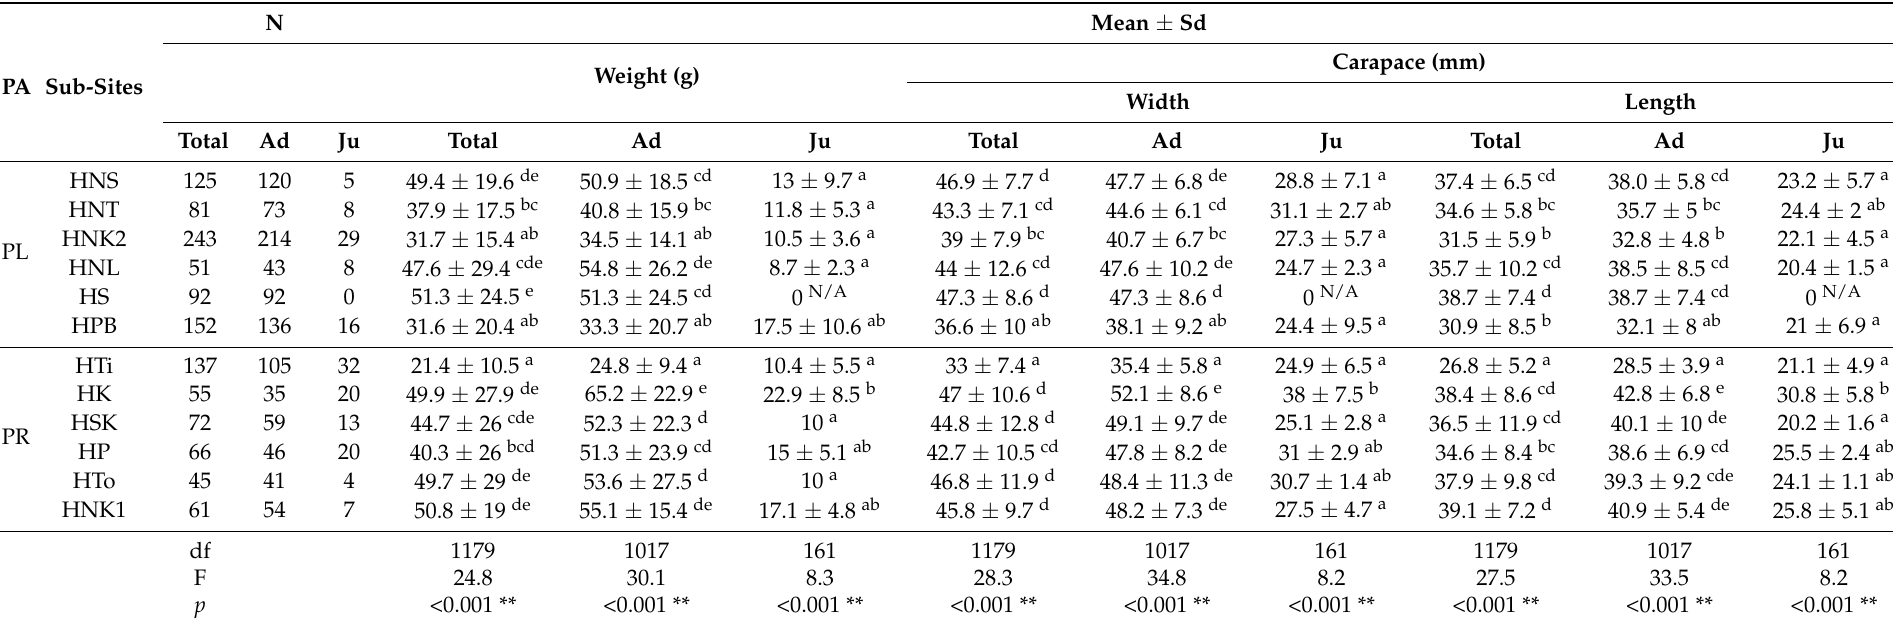
Table 3. Average body size of I. bhumibol in Phu Luang Wildlife Sanctuary (PL) and Phu Ruea National Park